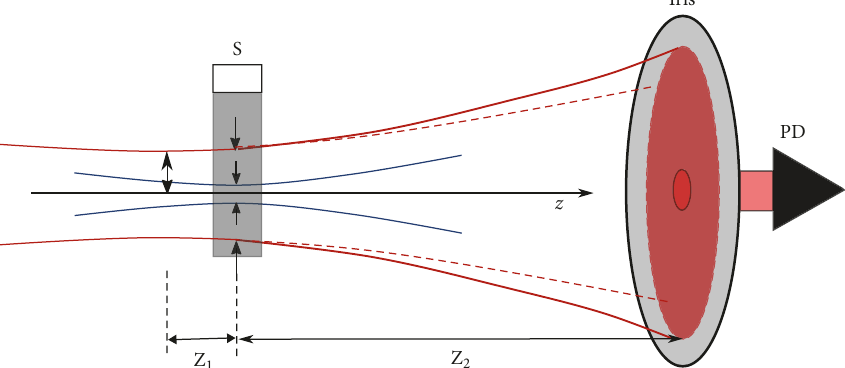
Figure 5: Representation of the positions of the laser beams in the sample for the two-beam thermal lens experimental setup. PD: photodetector. Dotted red line represents the trajectory of the probe beam without the thermal lens effect. Solid red line represents the actual trajectory of the probe